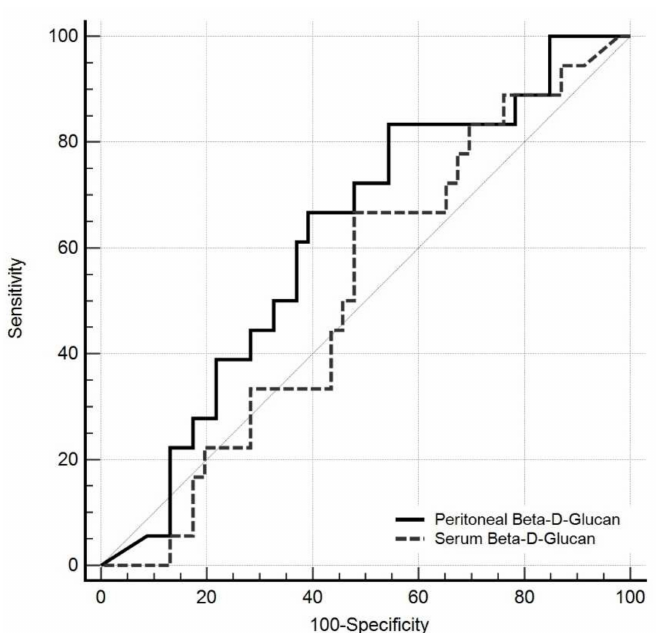
Figure 3. ROC curves of initial serum and peritoneal (1,3)-ß- D -glucan concentrations to diagnose intra-abdominal